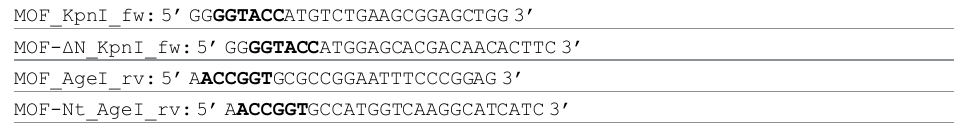
Table 2. Primers for subcloning of MOF mutant constructs from pFastBac-1 to